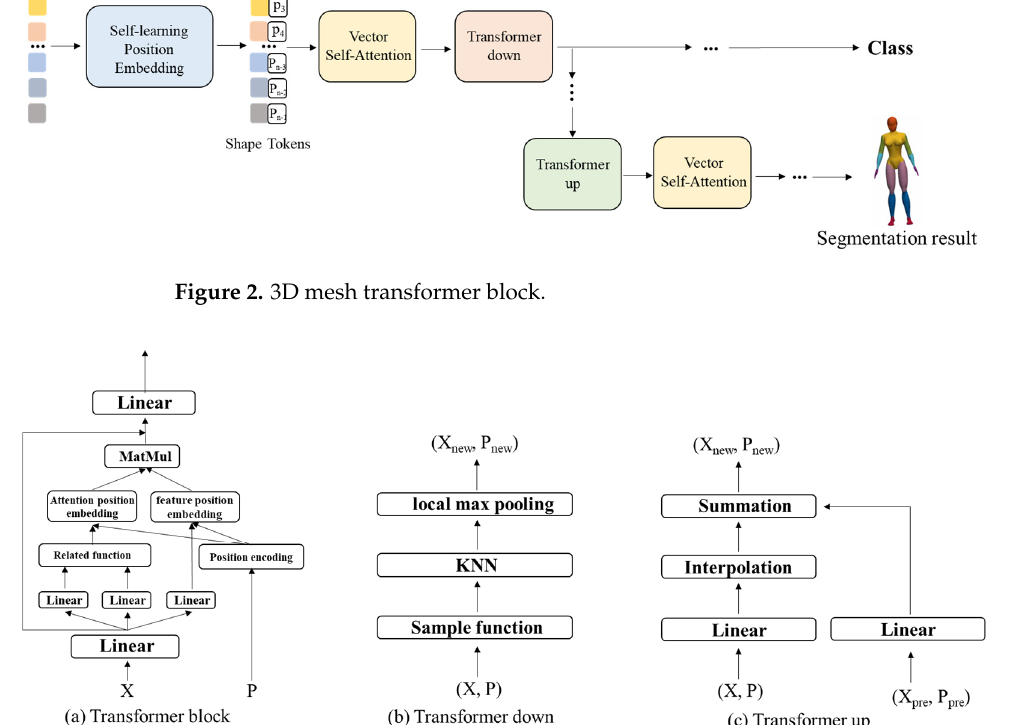
Figure 3. Internal implementation of transformer layer, transformer down layer, and transformer up layer.